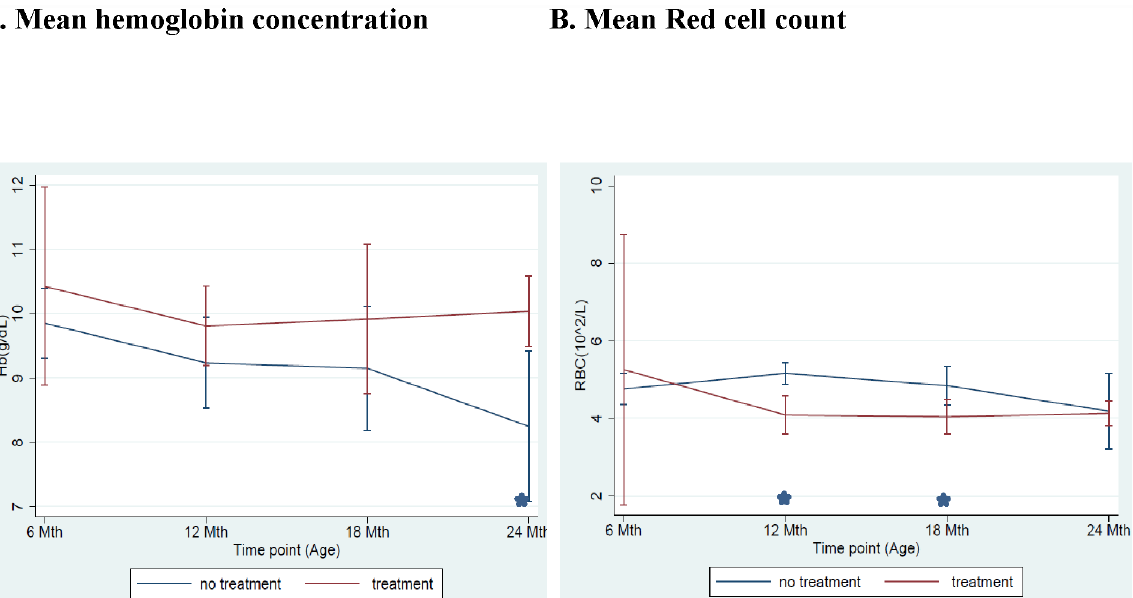
Fig 3. Comparison of mean A) hemoglobin concentration and B) RBC count by treatment status in HIV-1 infected children, Kisumu Breastfeeding Study, Kisumu, Kenya, July 2003- February 2009. ( * p <